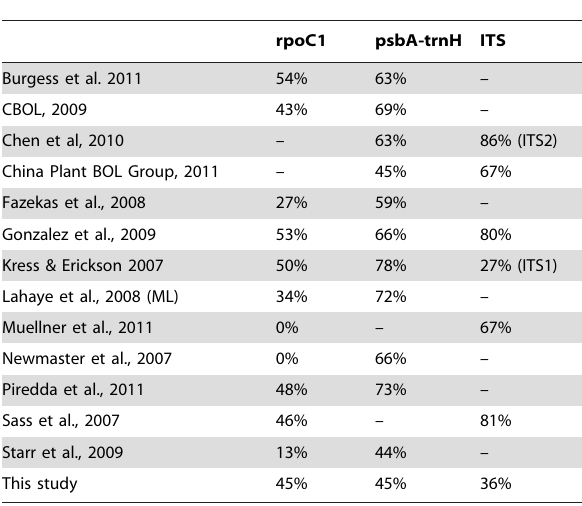
Table 3. Overview of species level identification success